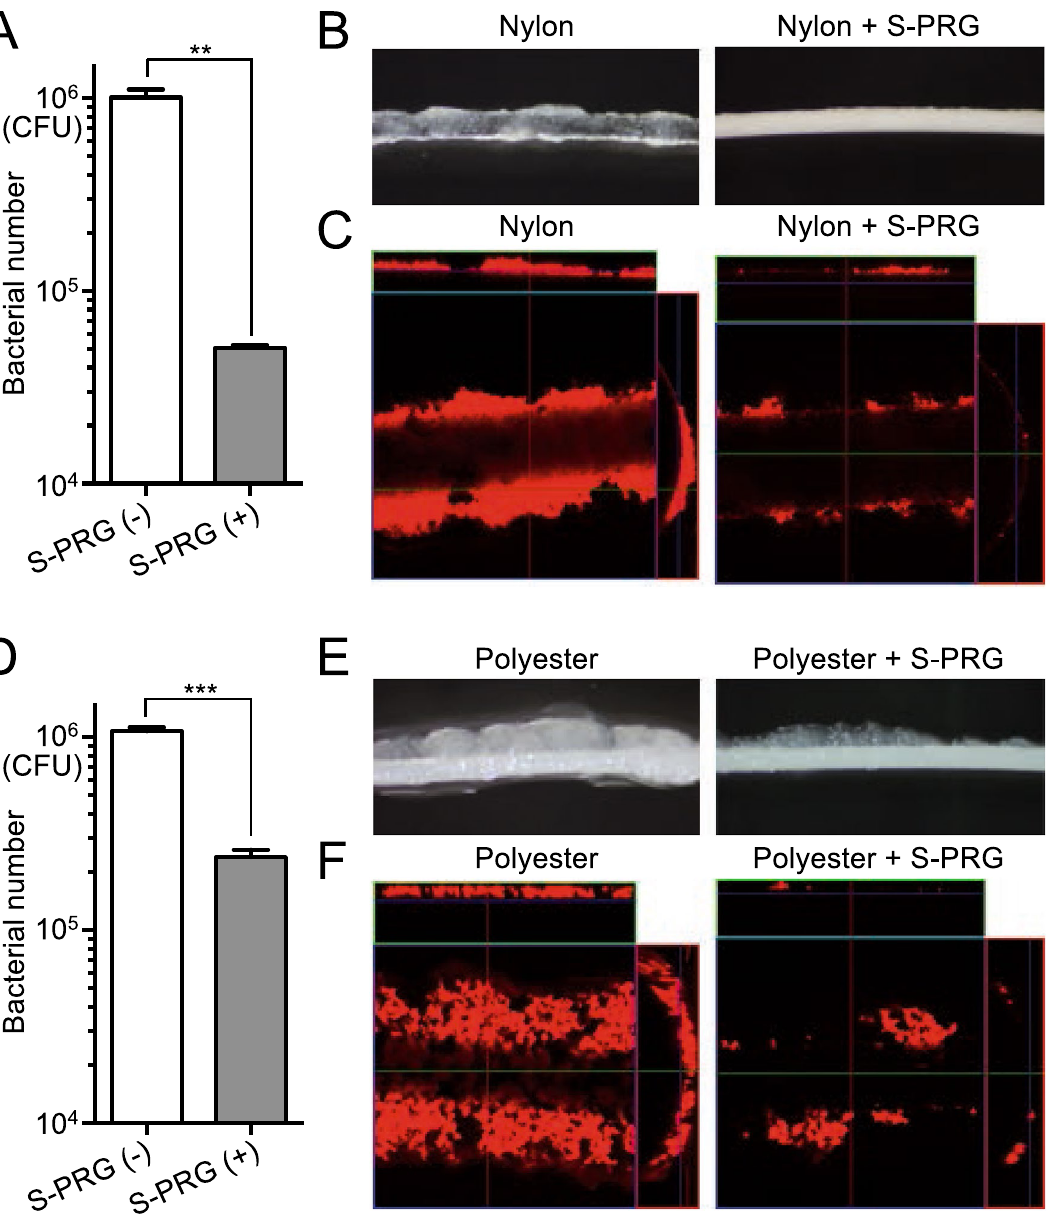
Figure 4. Biofilm formation of S. mutans on monofilaments. ( A ) Number of S. mutans adhering to nylon monofilaments with or without S-PRG filler. Significant differences were determined using a chi-square test. ** P < 0.01 between the groups. ( B ) Representative stereomicroscopic images of nylon monofilaments with and without S-PRG filler. ( C ) Representative confocal laser microscopic images of nylon monofilaments with and without S-PRG filler. Orthogonal views of z stacks composed of S. mutans cultured on nylon monofilaments. Bacterial cells adhering to the nylon monofilaments are stained red. ( D ) Number of S. mutans adhering to polyester monofilaments with and without S-PRG filler. Significant differences were determined using a chi-square test. *** P < 0.001 between the groups. ( E ) Representative stereomicroscopic images of polyester monofilaments with and without S-PRG filler. ( F ) Representative confocal laser microscopic images of polyester monofilaments with and without S-PRG filler. Orthogonal views of z stacks composed of S. mutans cultured on polyester monofilaments. Bacterial cells adhering to the polyester monofilaments are stained